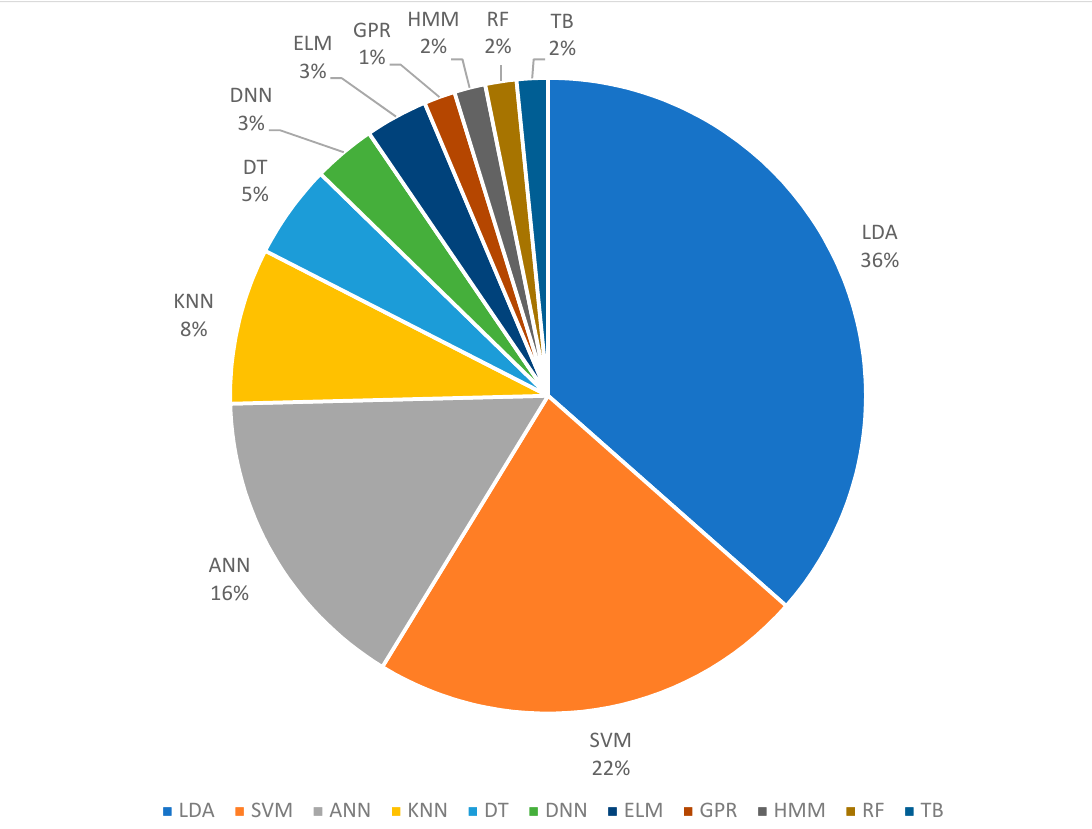
Figure 10. Percentages of the different classification algorithms reported in FMG literature ( n = 63).